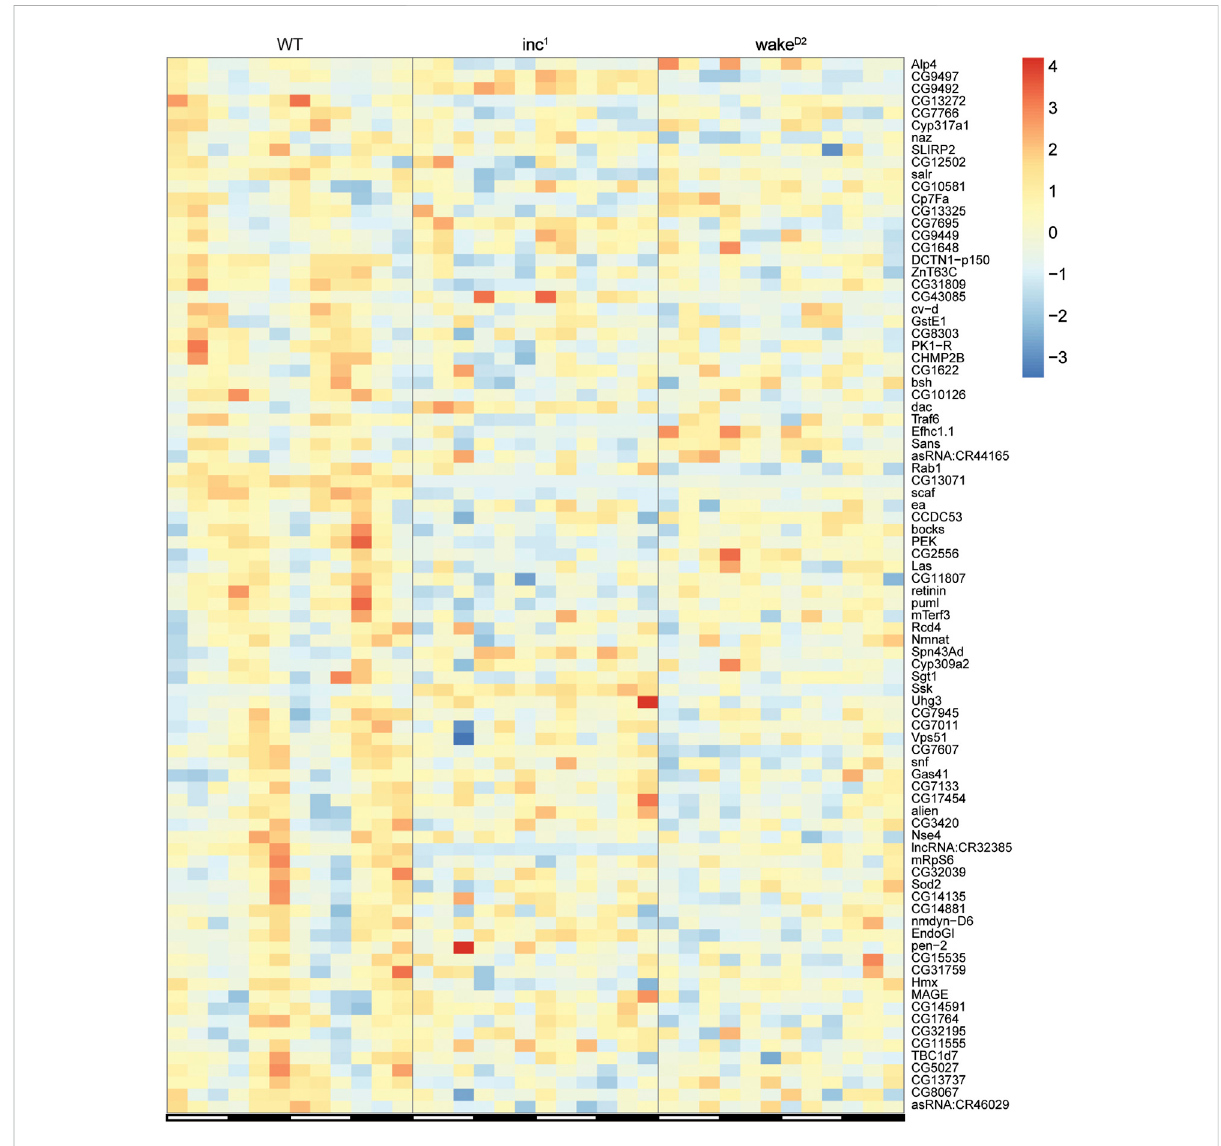
FIGURE 4 Expression of the loss of rhythmicity genes in chronically sleep deprived fl ies. Each row represents one gene, and each column represents one timepoint.Expression levelsarenormalizedtoeachgeneitselfanddataarealignedaccordingtothepeakexpressiontimein WT groupcalculatedby JTK cycle. The blocked horizontal bars below the panel correspond to the light-dark